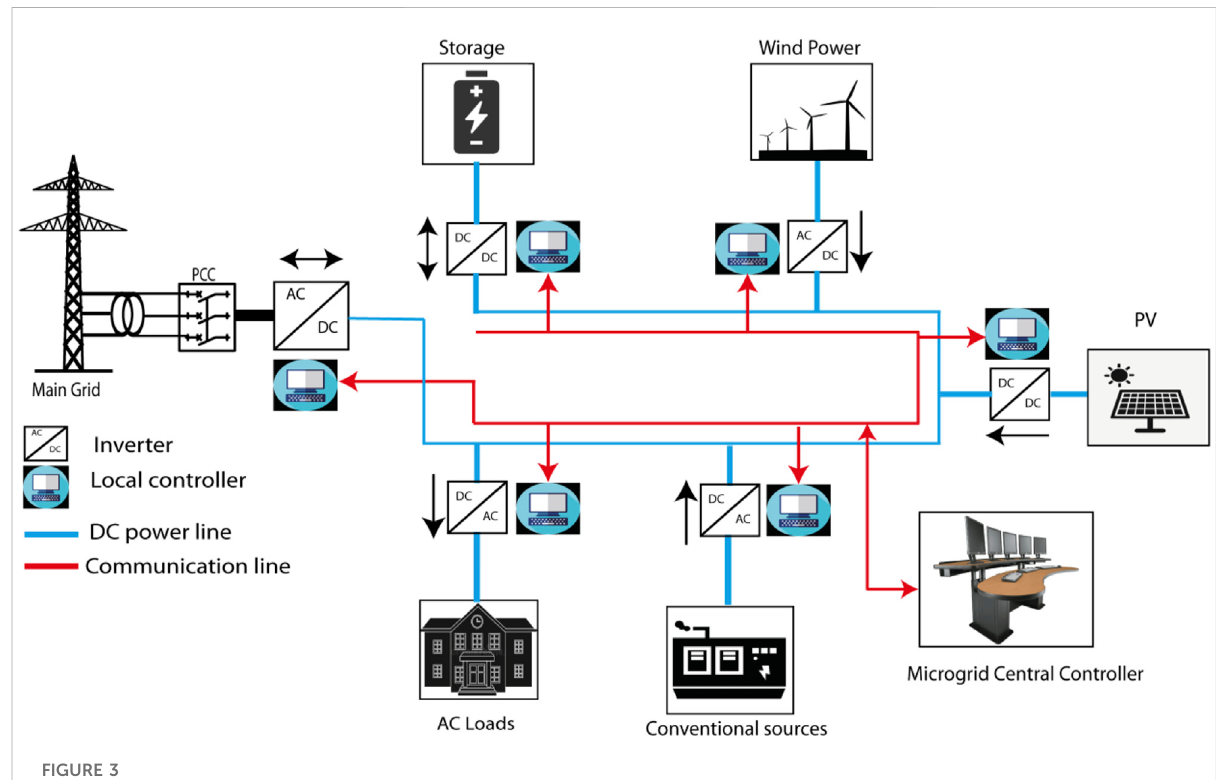
FIGURE 3 Architecture of centralized